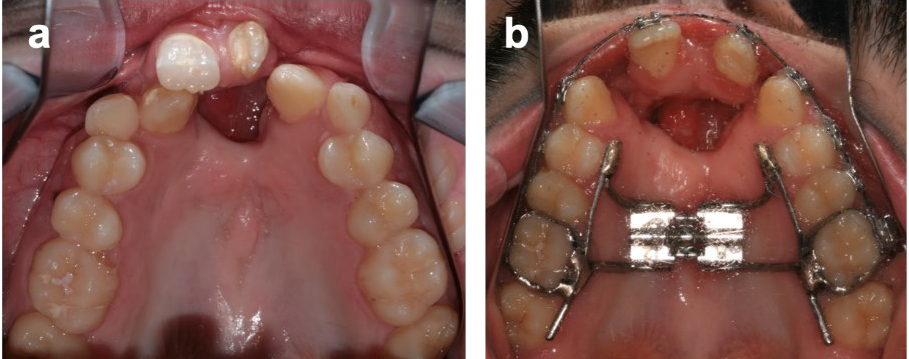
Figure 3. Upper arch before ( a ) and after ( b ) activation of hyrax-type appliance. After maxillary expansion with the hyrax-type appliance, Roth 0.018 prescription fixed appliances were placed in order to level and align the arches using a normal arch- wire sequence. The severe mandibular dental crowding (10.5 mm) and the protrusion of mandibular anterior teeth were solved through extractions of the first mandibular pre- molars . The mandibular canine’s retraction was performed on a 0.016 × 22 stainless steel archwire using NiTi closing coils against the posterior groups, and this was followed by a careful retraction of the mandibular incisors so as to prevent fenestrations and gingival recessions since the patient had a thin gingival biotype.